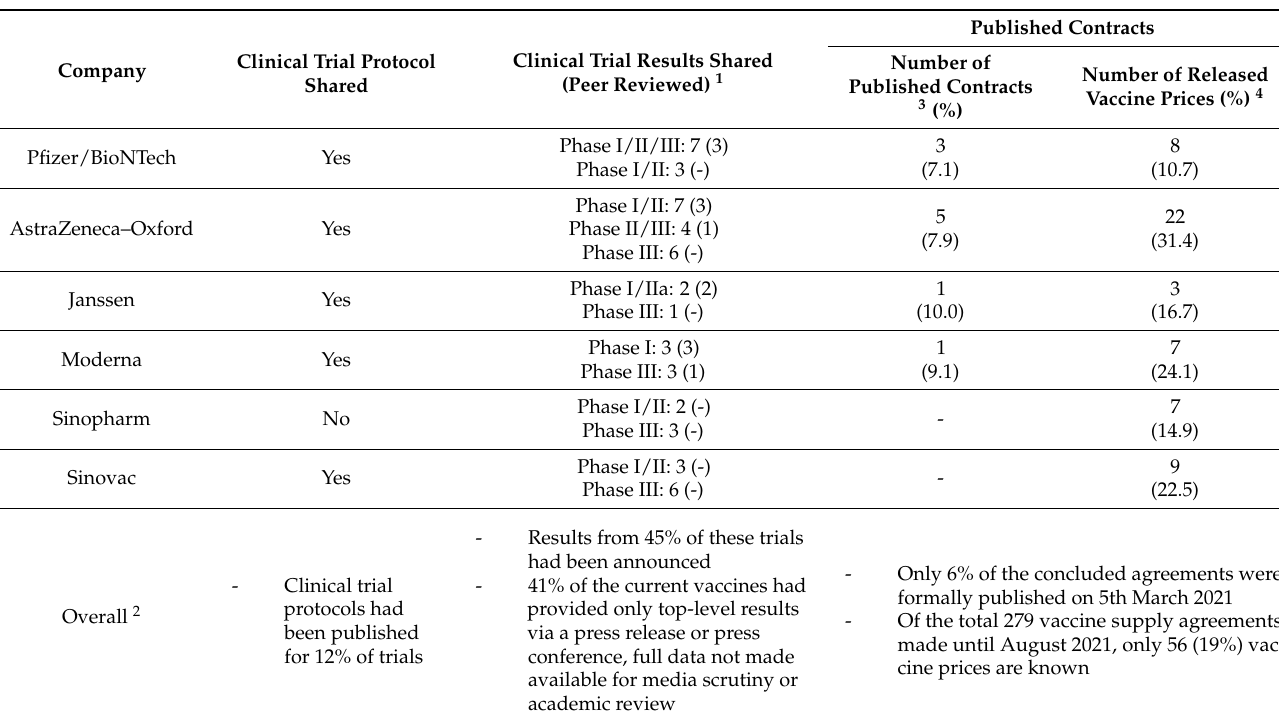
Table 3. Transparency of clinical trials and published contracts of EUL COVID-19